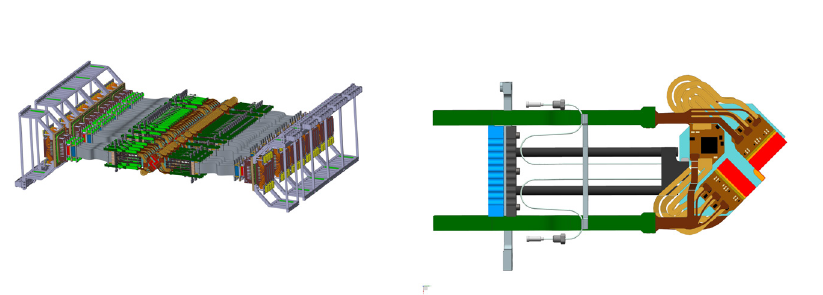
Figure 2: VELO upgrade detector (left) and single module